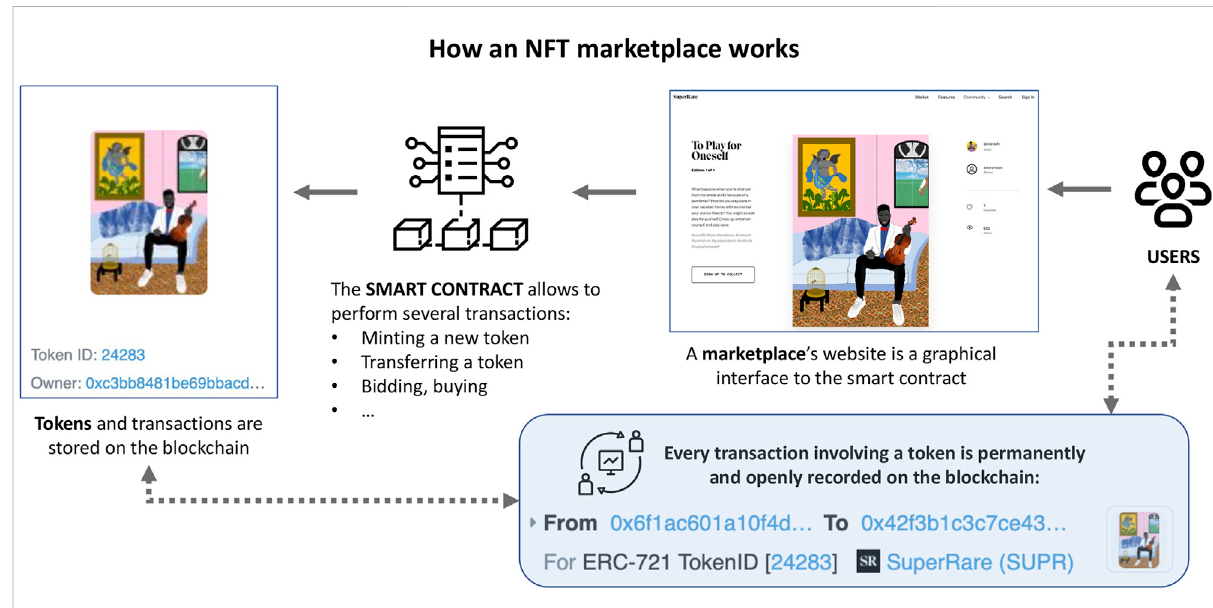
FIGURE 1 IllustrationofhowanNFTartmarketplaceworks.Themarketplace ’ swebsiteisaninterfacetooneormoresmartcontractsrecordingeventson a blockchain. The example is ‘ To Play for Oneself ’ by Osinachi, on